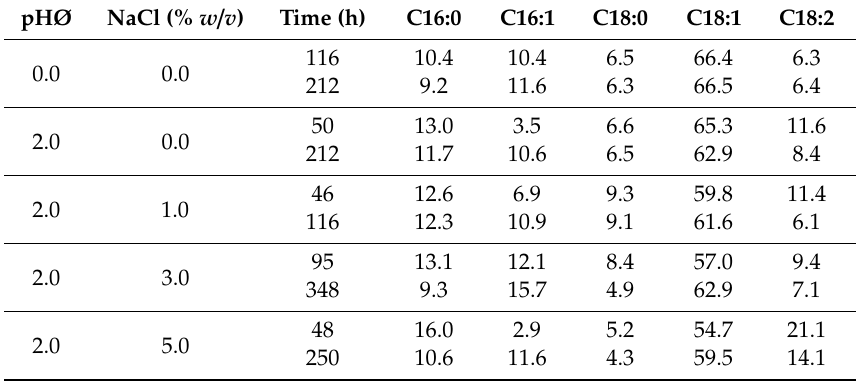
Table 3. Fatty acid composition (%, w/w) of Yarrowia lipolytica ACA-YC 5031 when grown in a glycerol-based media (70.0 g/L) blended with OMWs (2.0 g/L of phenolic compounds), in which different concentrations of NaCl (0.0%, 1.0%, 3.0%, and 5.0% w/v) were added. pHØ